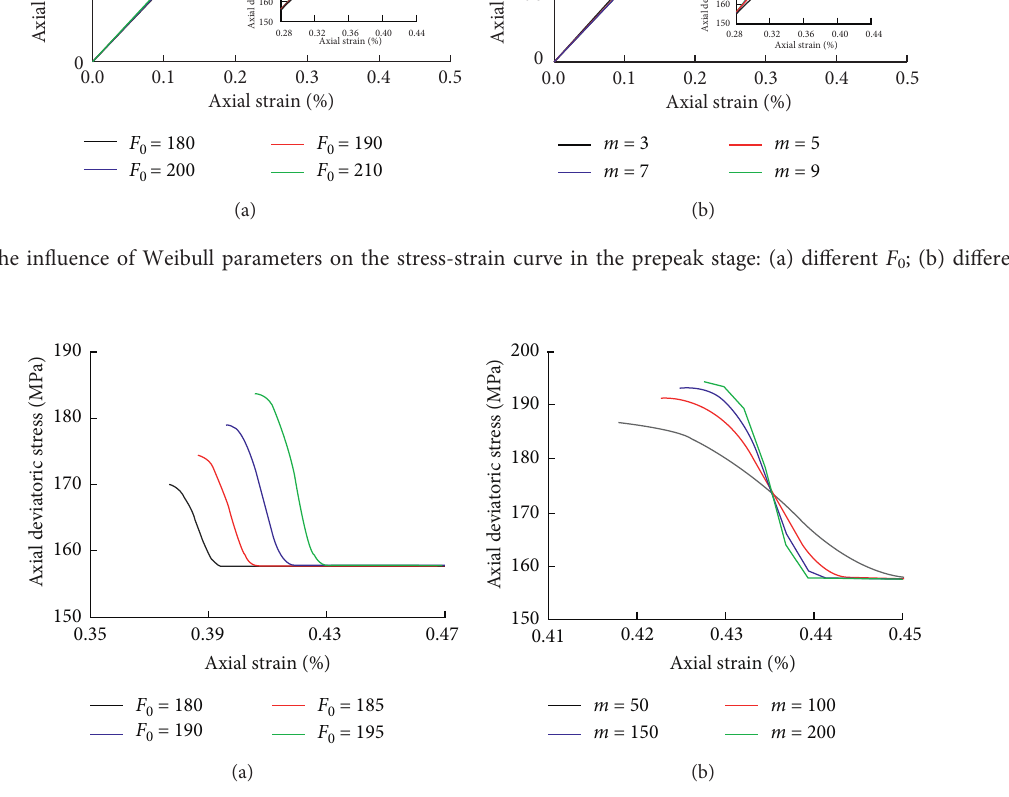
Figure 7: The influence of Weibull parameters on the stress-strain curve in the postpeak stage: (a) different F